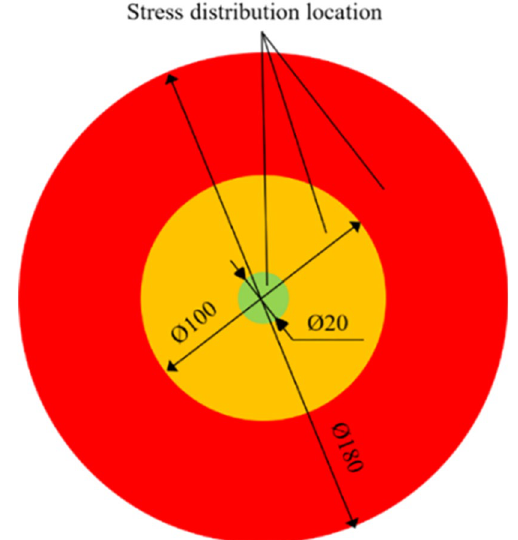
Figure 11 Stress added strategy